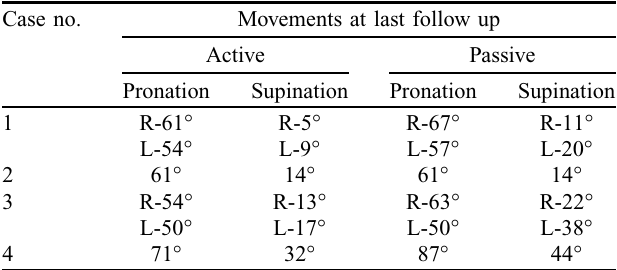
Figure 5. Photographs made almost 2 years after surgery showing good rotational movement of right forearm (Case no. 1). Table 2. Serial follow-up of active and passive rotational move- ments of